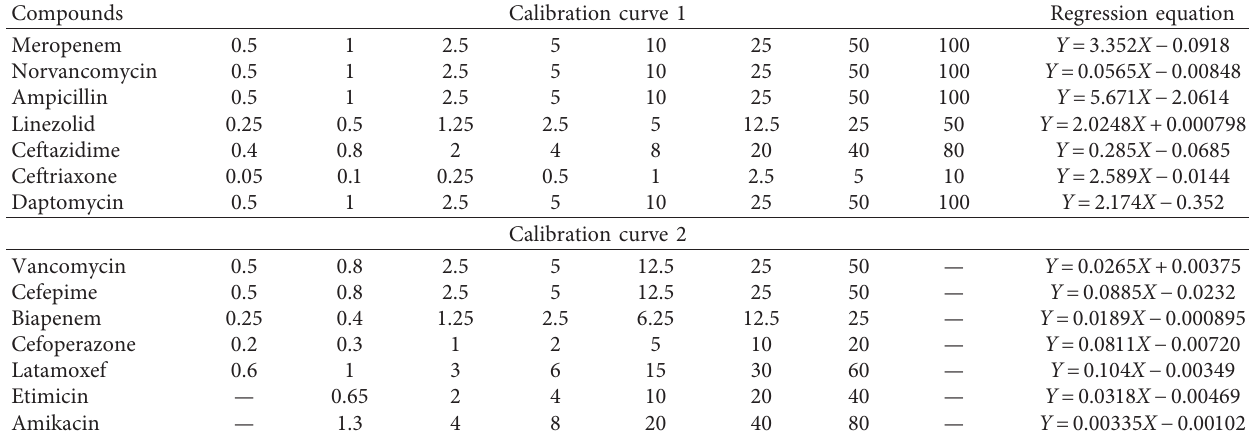
Table 2: Concentrations of calibrators ( μ g/mL) and regression equation.